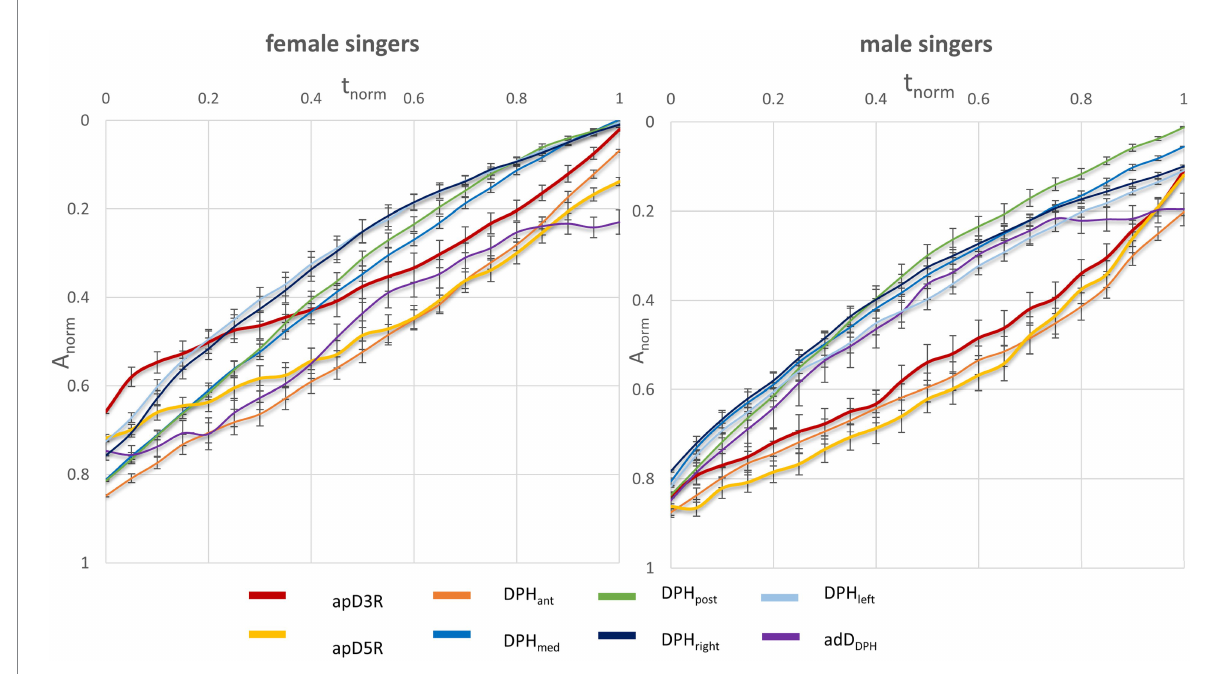
FIGURE 4 Female singers started at lower thoracic vital capacity levels compared to male singers. Mean movement curves of female (left) and male (right) normalized to vital capacity inspiration and expiration are displayed including standard error bars. The x-axis displays normalized maximum phonation time ( t norm ) and the y-axis displays the normalized curve amplitude ( A norm ) as a percentage of individual maximum inspiration and expiration. Each location of the respiratory system is displayed in a separate